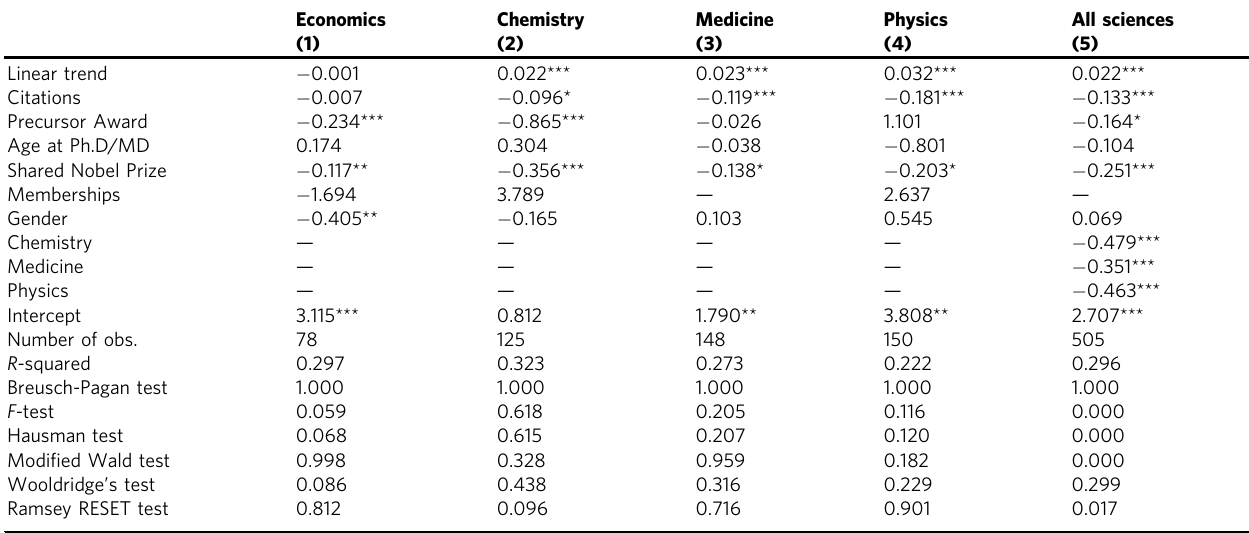
Table 5 presents results from calculating Eq. (1) for samples identi fi ed by column. The dependent variable is the number of years elapsed between the publication of a major scienti fi c breakthrough and the recognition of its author with the conferment of a Nobel medal. The lower panels of the table report results from several diagnostic tests. Breusch-Pagan and F -test examine the presence of random and fi xed effects,respectively, while Hausmantest helps to decide among the two. TheModi fi ed Waldtest examines the presence of group-wise heteroscedasticity, Wooldridge ’ s test inspects for serial correlation and Ramsey RESET test checks the overall model speci fi cation. ***, **, and * denote signi fi cance at the 1%, 5%, and 10% level,